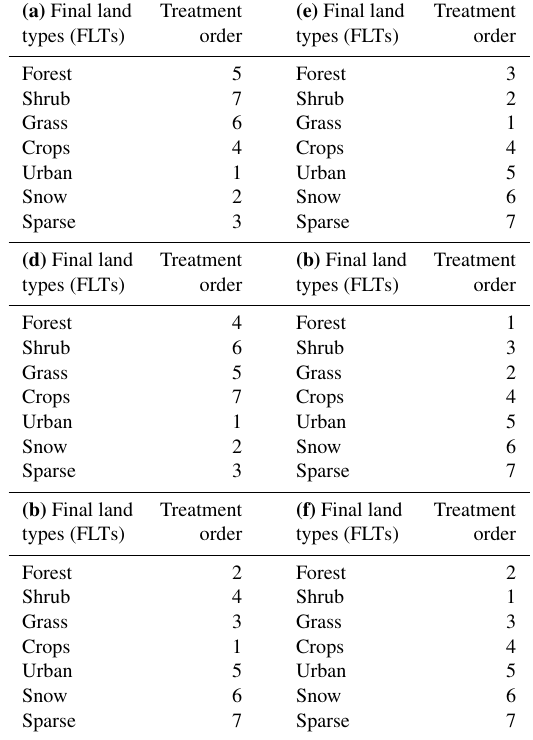
Table 8. Configurations of the treatment order for the sensitivity